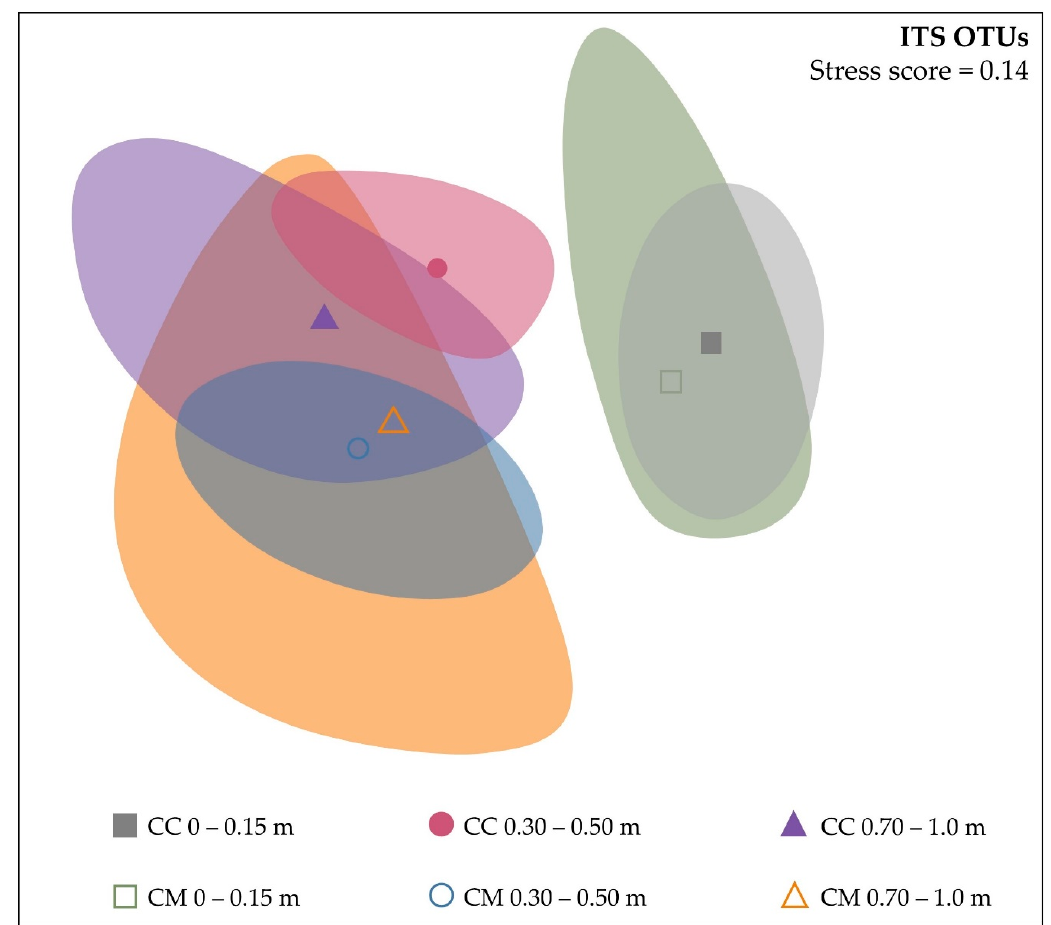
Figure 2. Dissimilarities between fungal (ITS) communities down the soil profile, as influenced by continuous cotton (CC) and cotton–maize (CM) crop systems, using non-metric multidimensional scaling (nMDS) of absolute abundance OTUs based on the square root transformation of Bray–Curtis dissimilarity, with a stress score of 0.14.